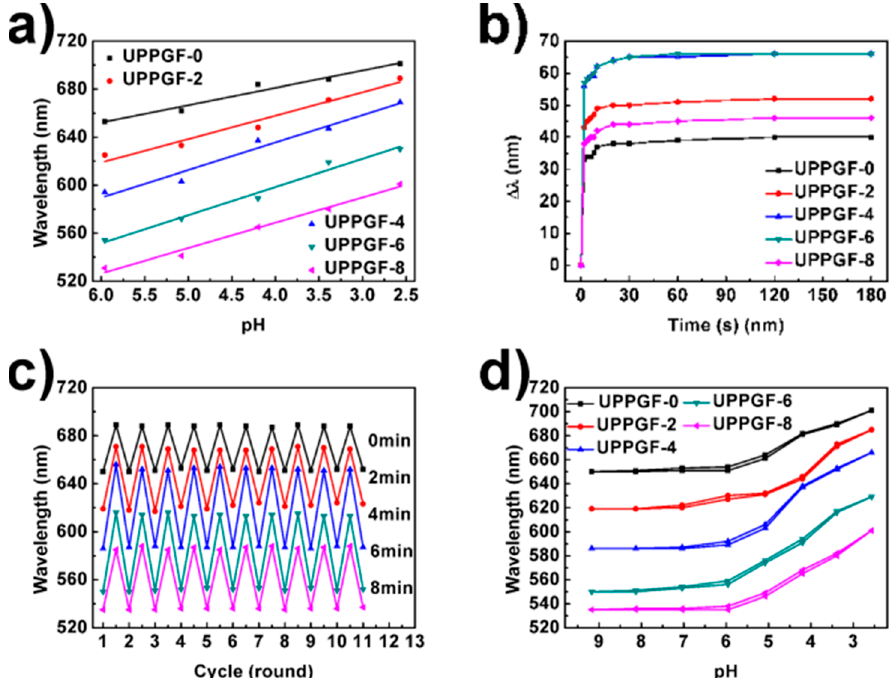
Figure 6. ( a ) Linear relation between UPPGF-x (x = 0, 2, 4, 6, 8 min) and pH; ( b ) response kinetics of UPPGF-x to a pH 3.39 buffer solution; ( c ) reversibility of UPPGF-x over 10 cycles of exposure to pH 9.17–3.39; and ( d ) hysteresis loops of the UPPGF-x sensors between pH 9.17 and 2.57.